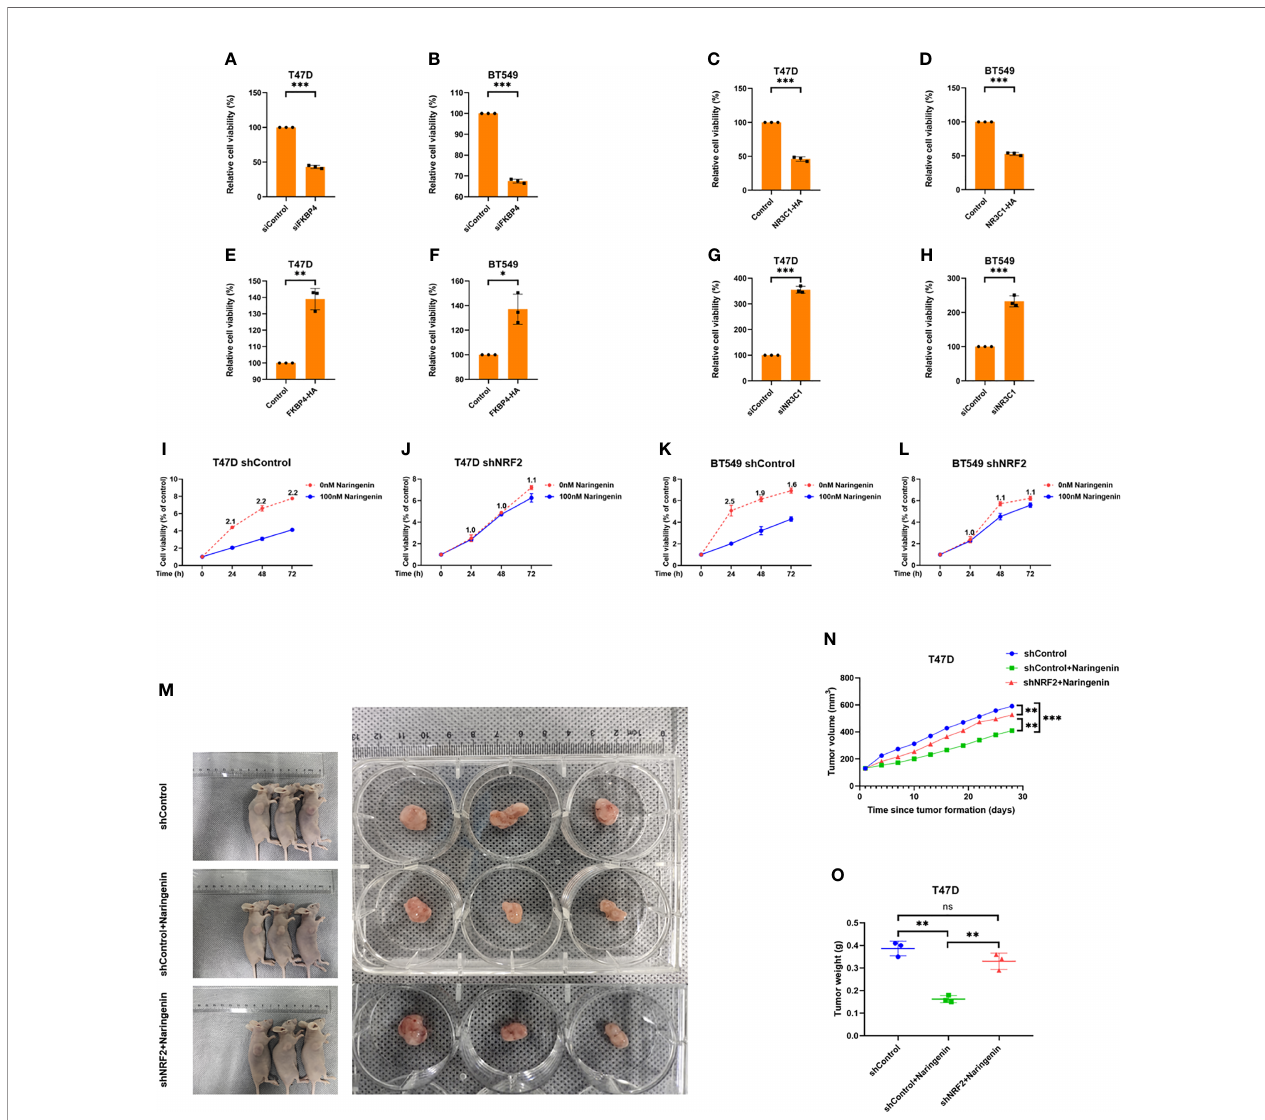
FIGURE 5 | FKBP4/NR3C1/NRF2 axis is involved in naringenin-restrained cell proliferation. (A, B) Bar chart showed silencing FKBP4 resulted in decreased cell viability of T47D and BT549 cells at 72 h (n = 3 independent biological replicates). (C, D) Bar chart showed overexpressing NR3C1 resulted in decreased cell viability of T47D and BT549 cells at 72 h (n = 3 independent biological replicates). (E, F) Bar chart showed overexpressing FKBP4 resulted in increased cell viability of T47D and BT549 cells at 72 h (n = 3 independent biological replicates). (G, H) Bar chart showed silencing NR3C1 resulted in increased cell viability of T47D and BT549 cells at 72 h (n = 3 independent biological replicates). (I – L) Line chart showed knockdown of NRF2 by shRNA attenuated naringenin-restrained cell proliferation in T47D and BT549 cells treated by 100 nM naringenin, numeric representation at each dot is cell viability fold change of 0 and 100 nM naringenin treatment (n = 3 independent biological replicates). (M – O) The macroscopic appearance, volume and weight of subcutaneous tumors in mice (n = 3/group) transplanted with T47D cells treated with shControl, shControl + Naringenin, and shNRF2 + Naringenin. *p <0.05, **p <0.01, ***p <0.001, ns,